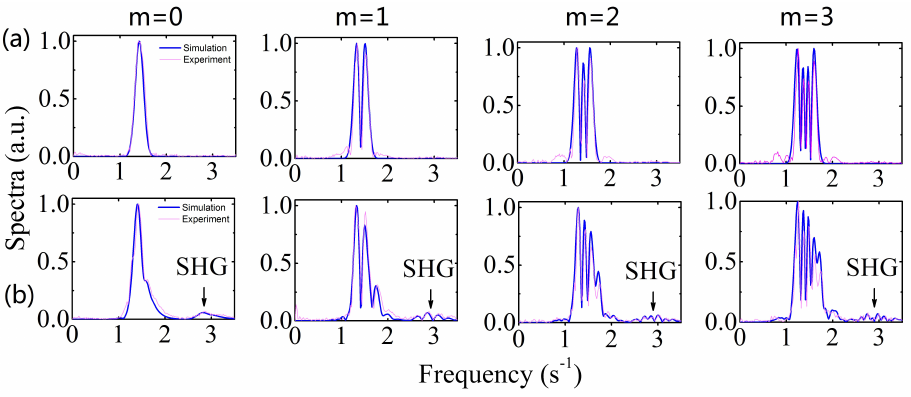
Figure 14. The spectra of the nonchirped HG wave pulses calculated at x = 7.39 m, with t 0 = 2.5 s and C = 0. ( a ) The measured linear spectra with a 0 = 6 mm ( ε = 0.05); ( b ) the measured nonlinear spectra with a 0 = 21 mm ( ε = 0.17). Blue curves correspond to simulations based on Equation (1); the red curves denote the